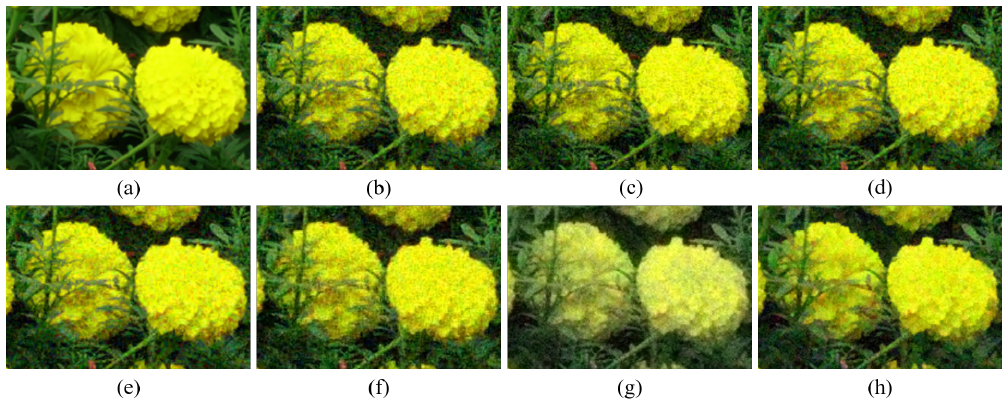
Figure 15. Showing the enlarged regions of Figure 14. ( a ) Original ( b ) ICC [12], ( c ) DNet [13] ( d )